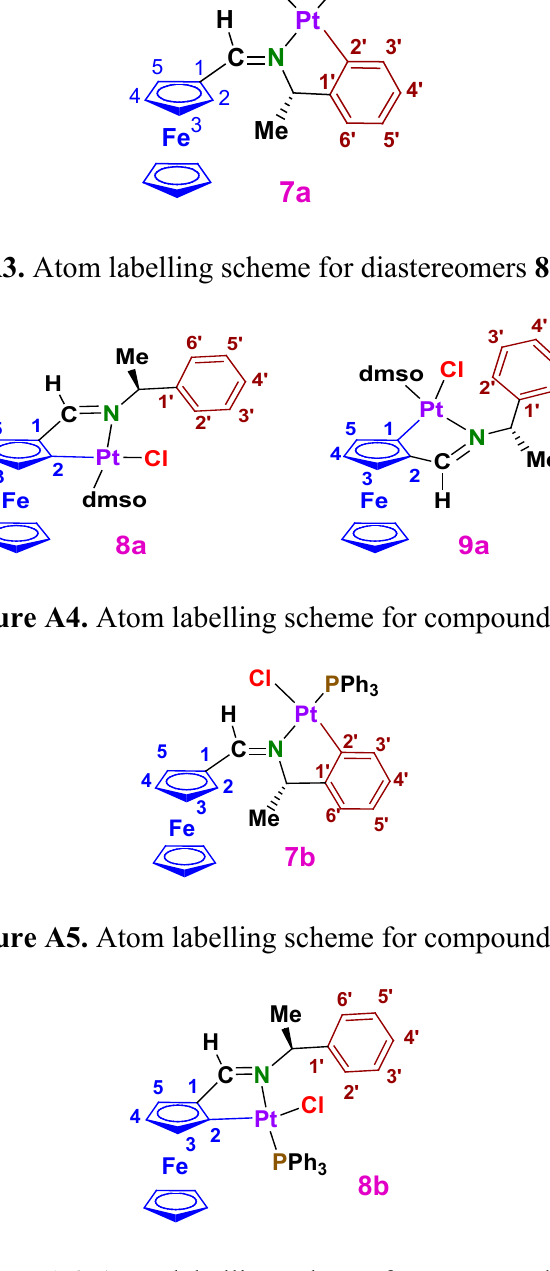
Figure A6. Atom labelling scheme for compound 9b